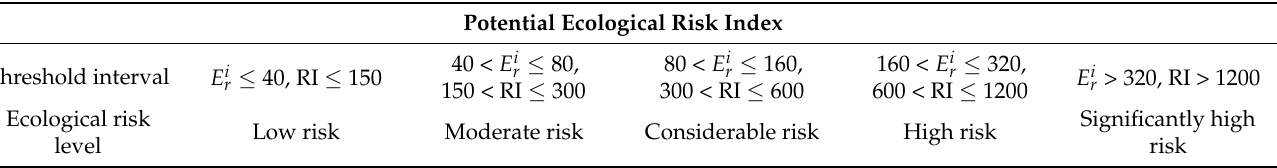
Table 2. Evaluation index and grading standard of potential ecological risk